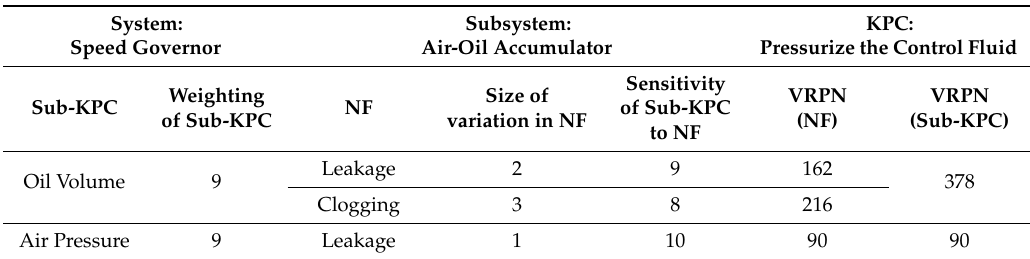
Table 14. VMEA form—air-oil accumulator example.